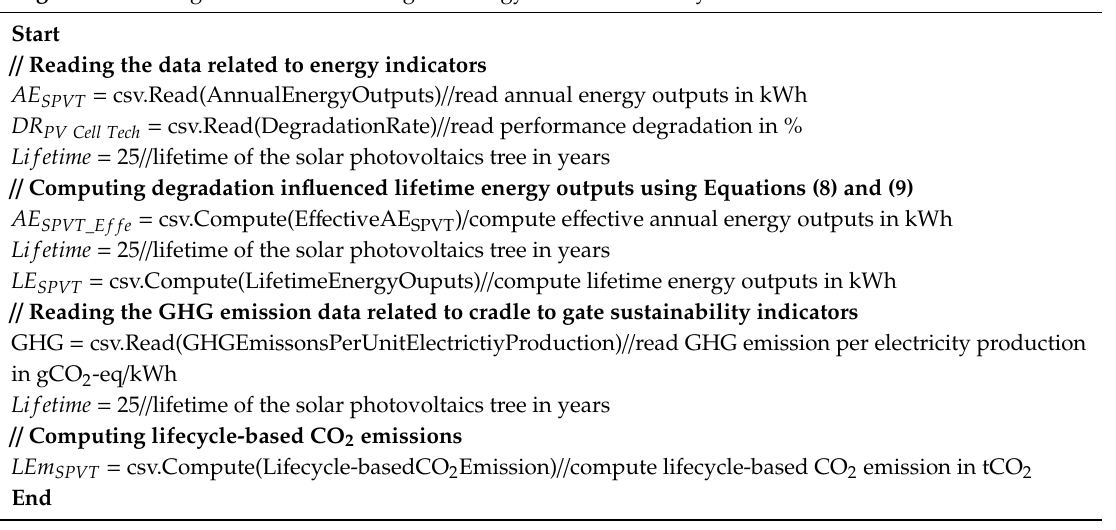
Algorithm A1: Algorithm for evaluating the energy and sustainability indicators